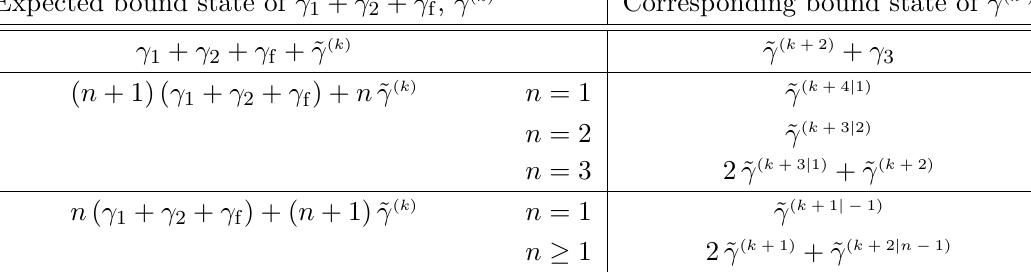
Table 2 . Bound states between γ and secondary states resulting from γ 3 interacting with ˜ γ ( k 0 ) for k 0 > k